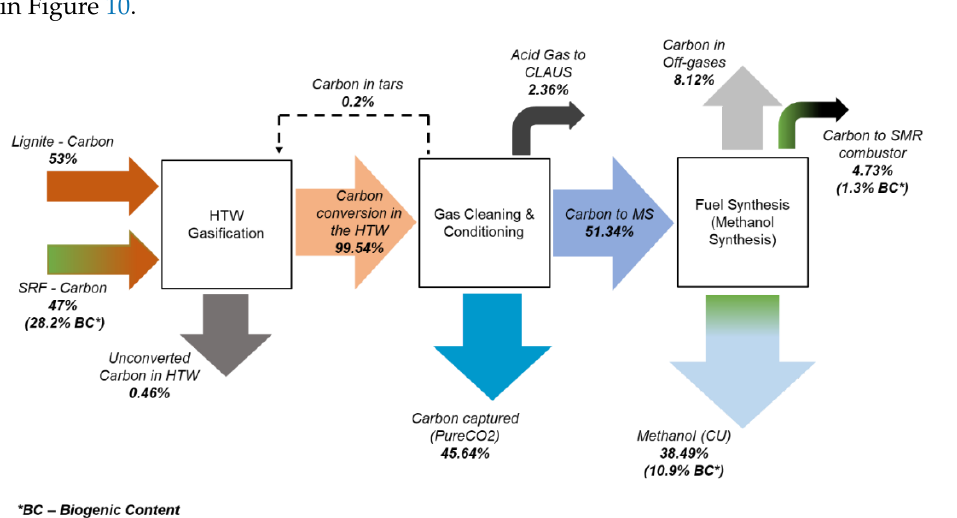
Figure 10. Carbon balance of the process for case 2 (50/50 LEG/SRF feedstock).